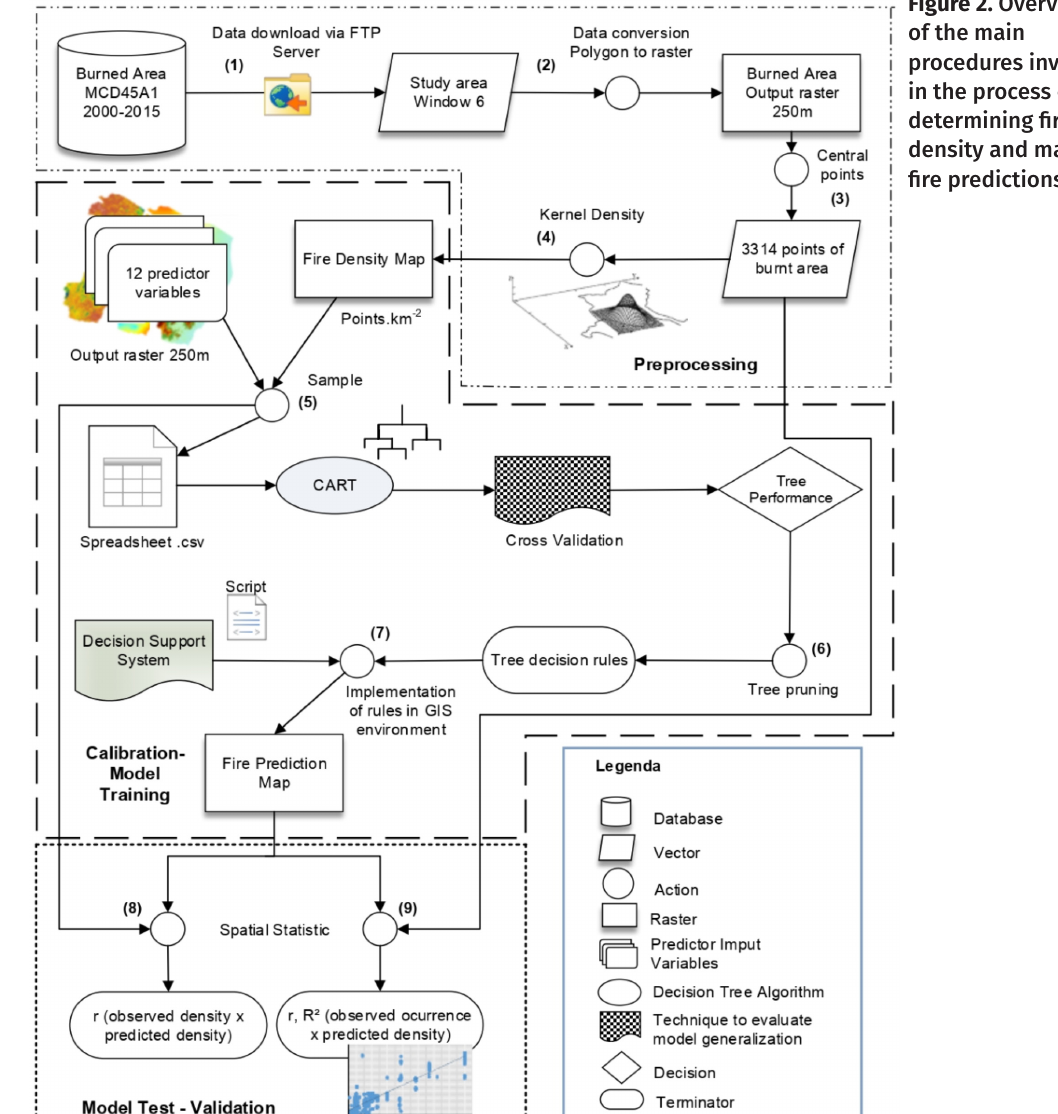
Figure 2. Overview of the main procedures involved in the process of determining fire density and making fire